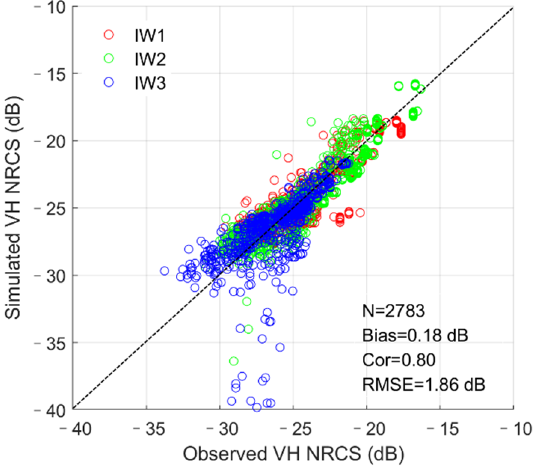
Figure 5. Comparison between the VH NRCS values simulated by S1IW.NR and observed by Sentinel-1 SAR in Dataset 1. Red, green, and blue circles stand for samples in IW1, IW2, and IW3, respectively.